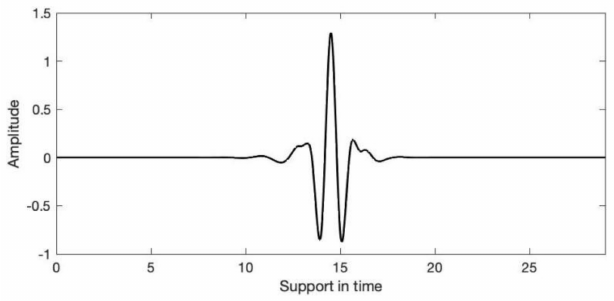
Figure 4. The coif5 wavelet